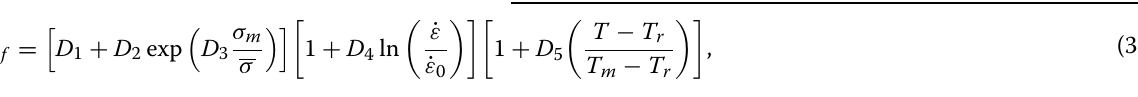
contact condition appreciably changes with friction